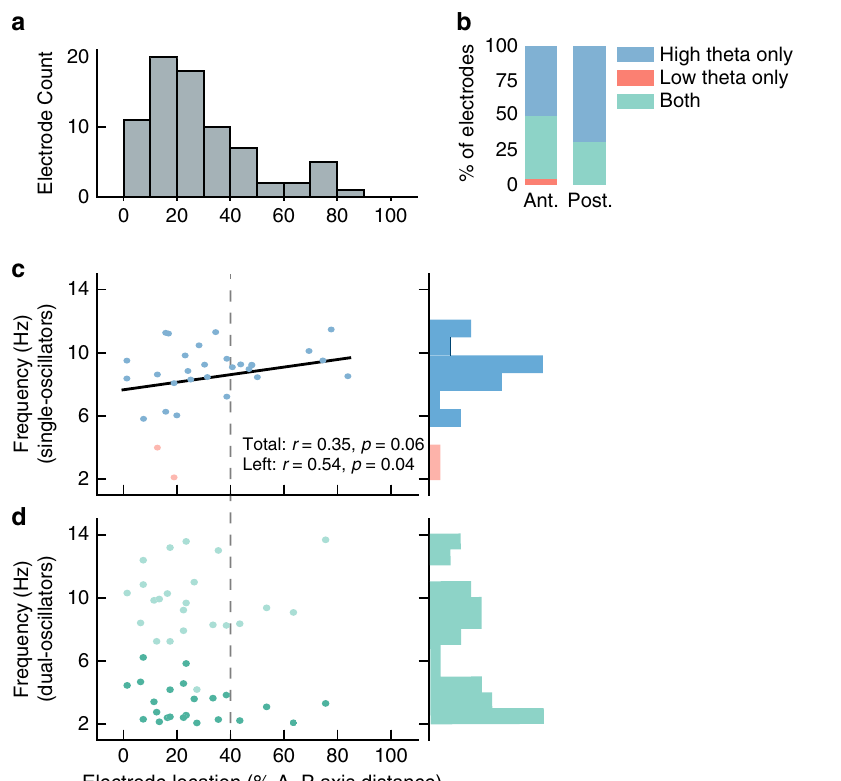
Fig. 3 Oscillation properties across frequency and space. a Distribution of electrode locations along the hippocampus anterior – posterior (AP) axis. b Proportions of dual oscillators and single oscillators for anterior and posterior hippocampus. Source data are provided as a Source Data fi le. c Frequencies and hippocampal localizations of single oscillators across subjects. Black line indicates the fi t between frequency and AP position for all high-theta electrodes in both hippocampi. Pearson r correlations between electrode location and frequency are reported for both hippocampi and for the left hippocampus alone. Gray dotted line indicates the split between anterior and posterior hippocampus. d Frequency and localization of dual oscillators. Dark green represents the slower